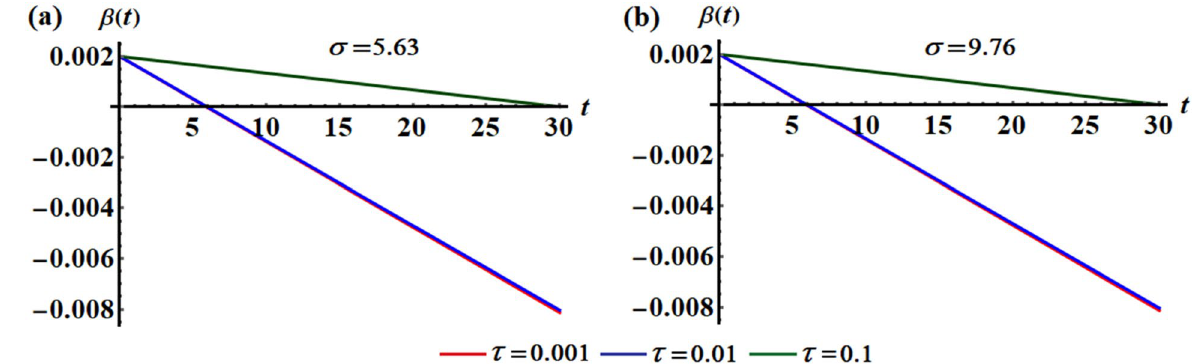
Figure 10. Shows the temporaly histories of β when L = 0.5 and τ( = 0.001, 0.01, 0.1 ) at: ( a ) σ = 5.63 , ( b ) σ = 9.76 .